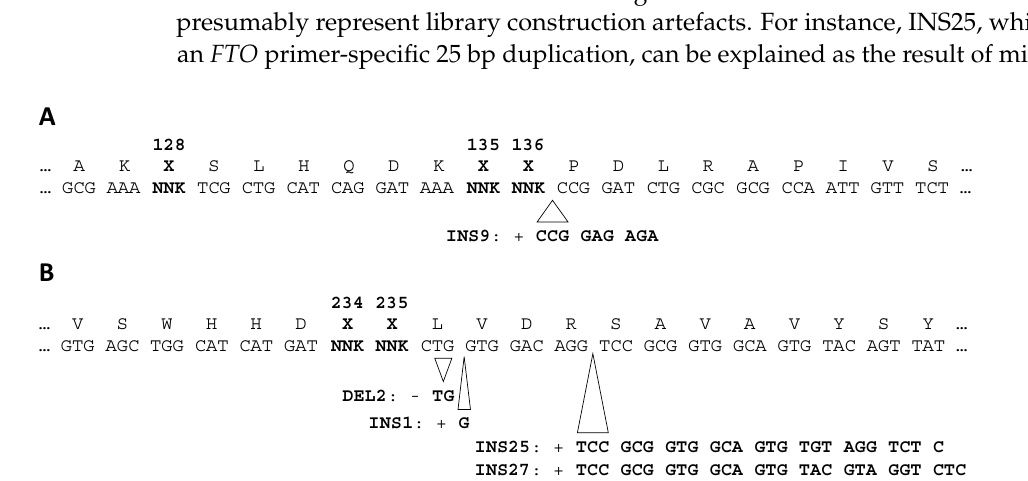
Table 1. Frequency evolution of alkB and FTO canonical (CAN) and indel (INS, DEL) clones during panning as derived from the Illumina sequencing output. alkB FTO Total Paired Library